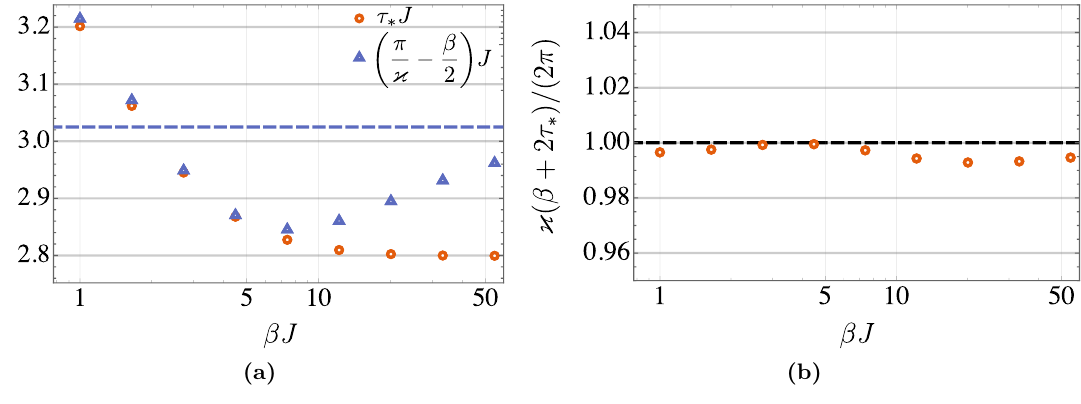
Figure 9. (a) Plots of τ ∗ and π − β as functions of the inverse temperature for the q = 4 SYK model. { 2 The dashed line indicates the β → ∞ limit of the second function. (b) The quantity { ( β + 2 τ ∗ ) / (2 π ) (cid:0) (cid:1) (or { 1 + τ ∗ in dimensionless units) that appears in the analyticity domain bound π